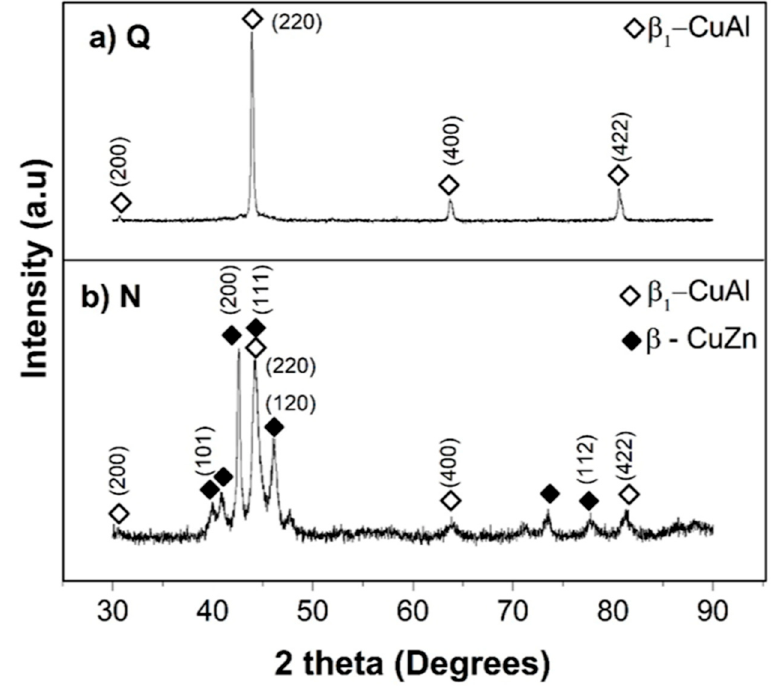
Figure 1. X-ray di ff raction (XRD) patterns corresponding to samples subjected to ( a ) quenching and ( b ) normalizing.